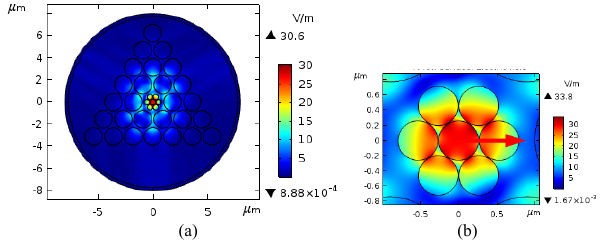
FIGURE 2. 2D view of Mode field pattern of proposed PCF for x-polarization at 1.33 μ m wavelength for (a) whole and (b) core region.